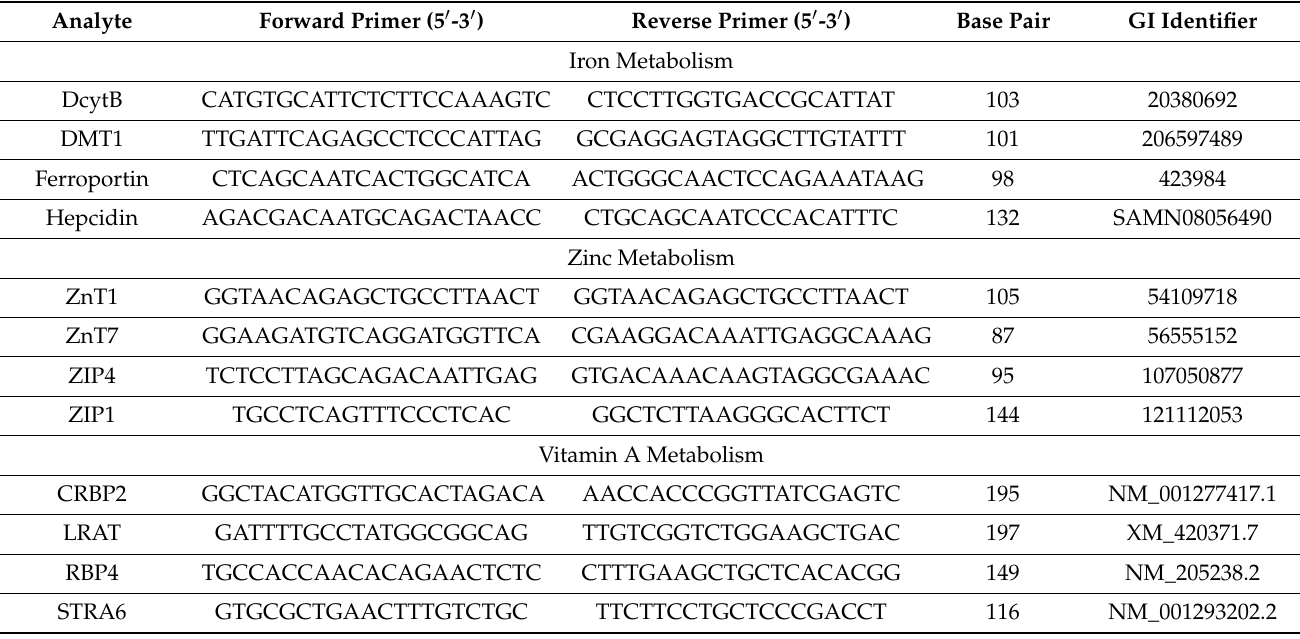
Table 1. DNA primer sequences used in this